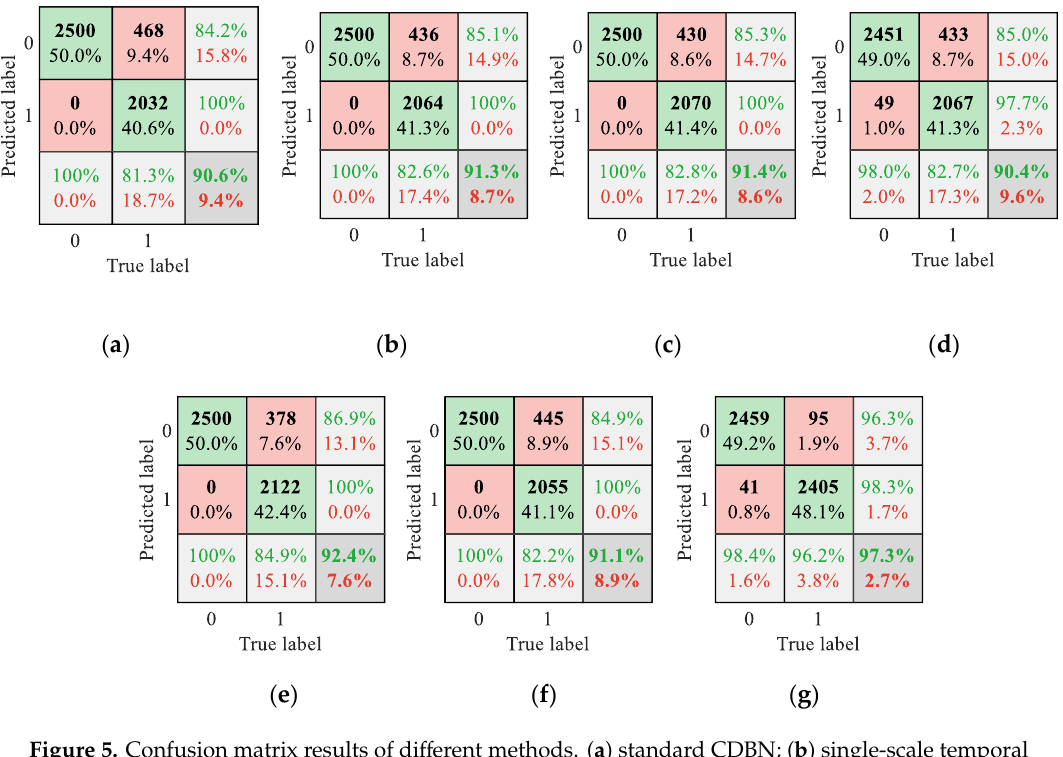
Table 7. Recognition accuracy of each health condition (%).